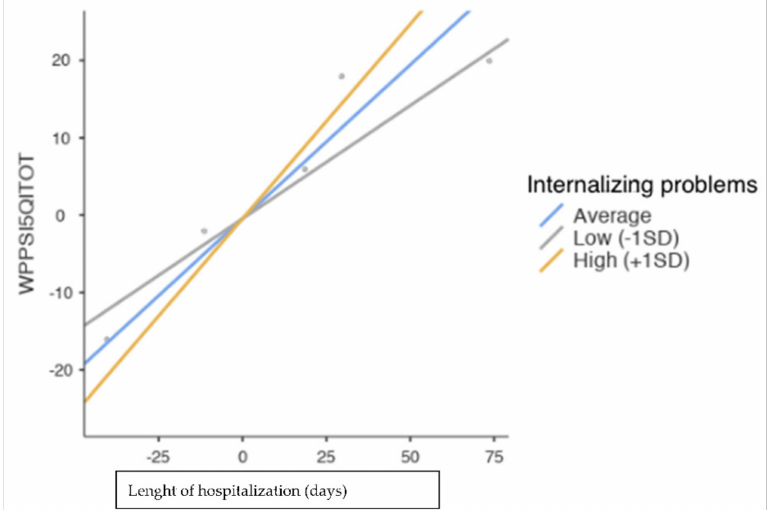
Figure 1. Simple Slope